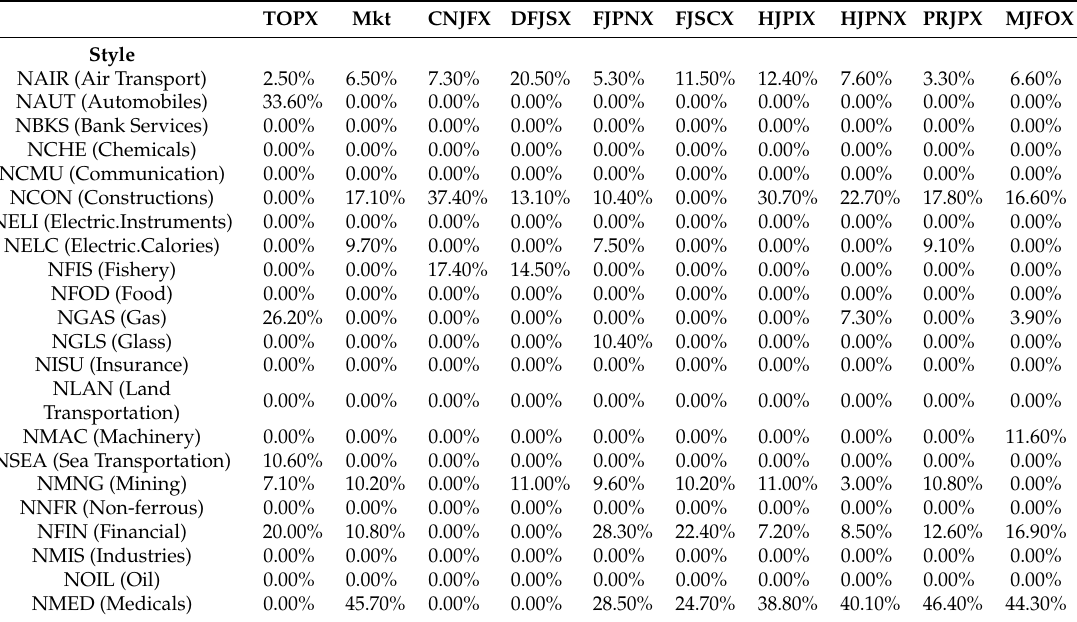
Table 7. Mutual fund exposures to Japanese sectors from April 2005–March 2016.